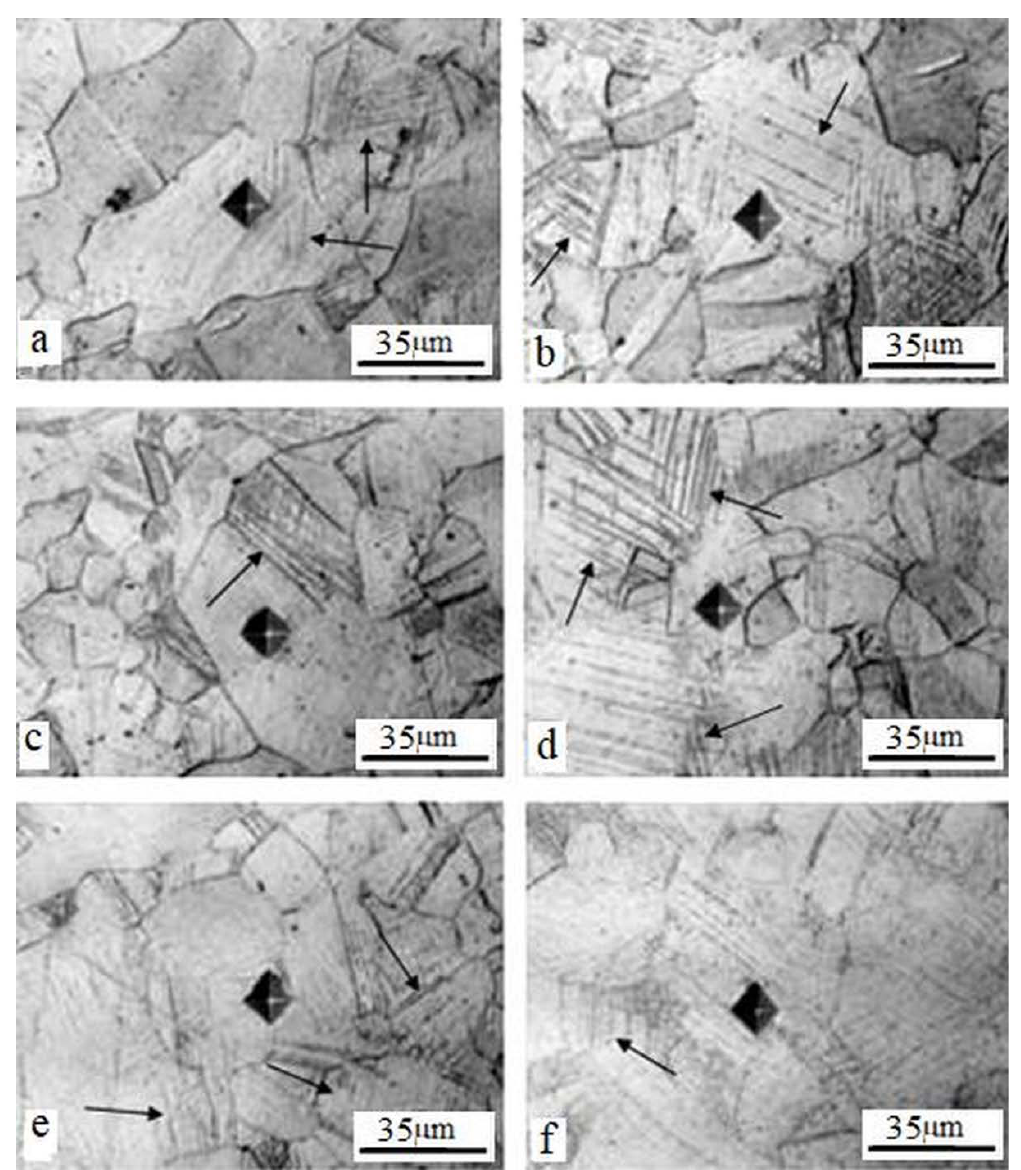
Figure 3. AISI 316L austenitic steel. Evolution of changes in the microstructure of a sample at a cross section as it approaches the surface that has been subjected to friction for 1 hour (sliding lines are marked with